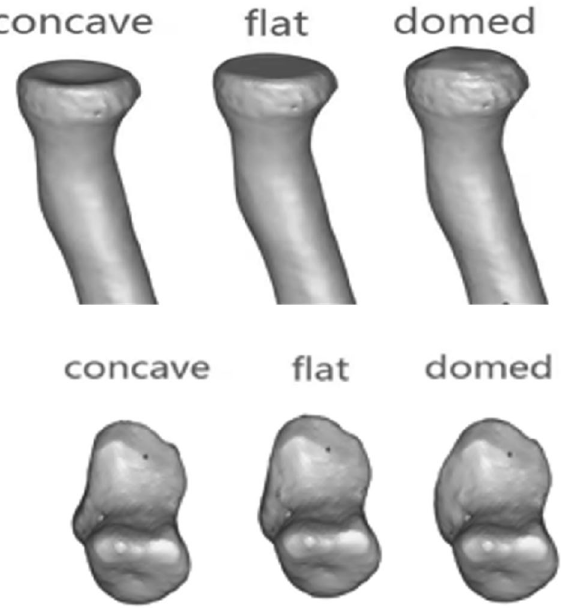
Figure 6. The patterns of the morphologic features of the radial head and radial notch, concave, flat, and domed, are